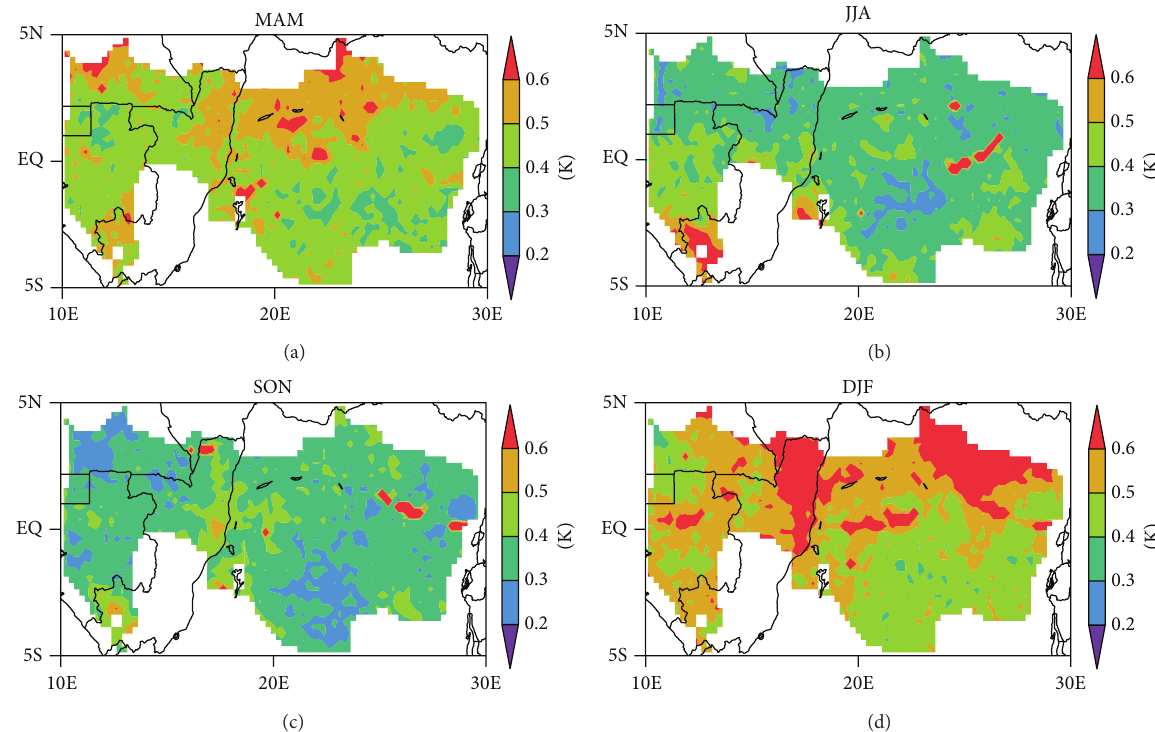
Figure 8: Standard deviation of the remotely sensed LST anomalies at 6:30 a.m. over Congo rainforests for the following seasons: (a) MAM, (b) JJA, (c) SON, and (d) DJF.